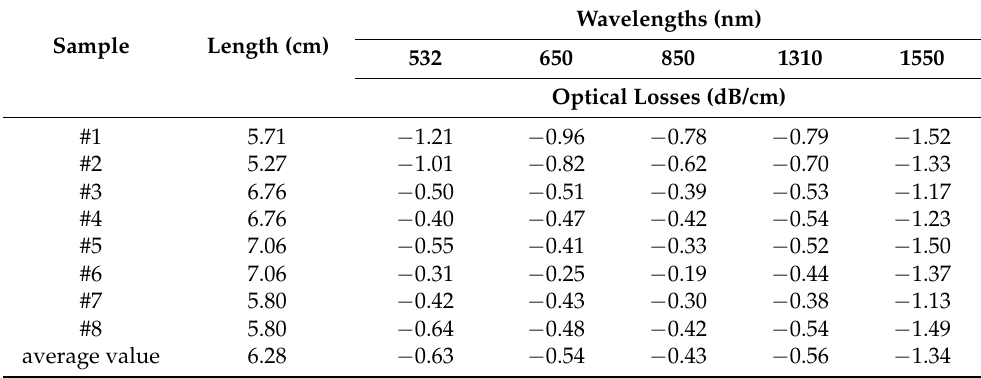
Table 1. Average values of the optical losses measured by the cut-back method at wavelengths 532, 650, 850, 1310 and 1550